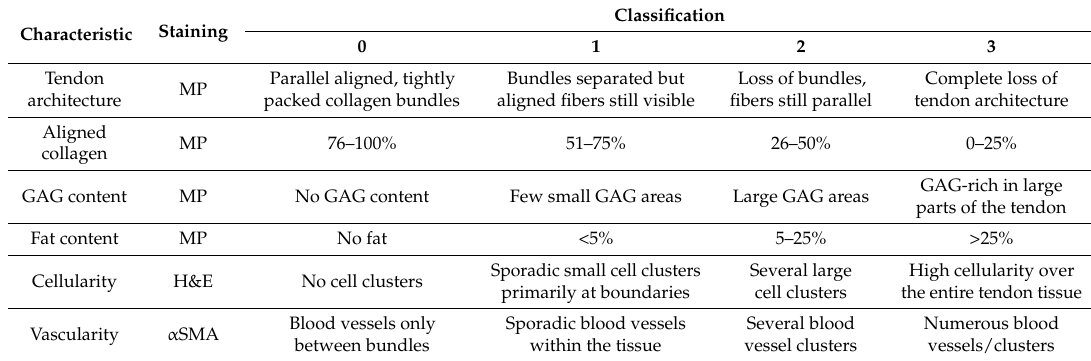
Table 2. Classification of histological